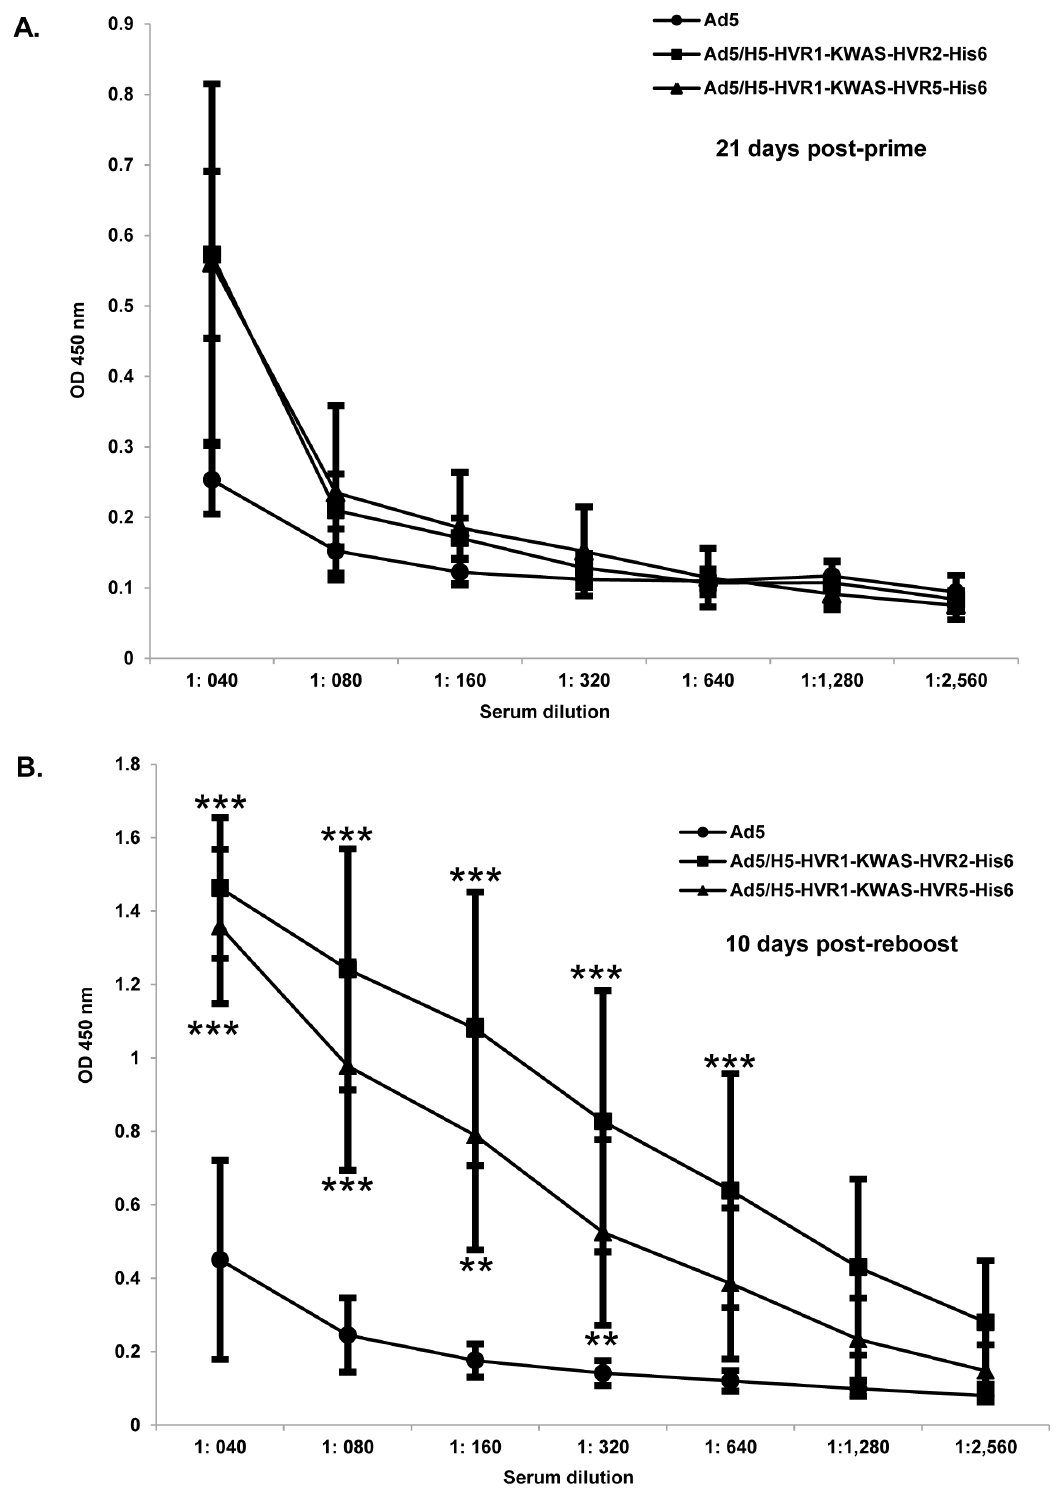
Figure 5. Multivalent vectors elicit an invivo anti-KWAS immune response. BALB/c mice (n=8) were primed, boosted, and reboosted with 1 6 10 10 VP of Ad vectors (Figure 4A). A–B) Post-prime and post-reboost serum was collected at various time points for ELISA binding assays. 1 m M of purified KWAS (PCEWDEAELDKWASNLEEEDDDNE) antigenic peptide was bound to ELISA plates. Residual unbound peptide was washed from the plates. The plates were then incubated with immunized mice serum and the binding was detected with HRP conjugated secondary antibody. OD absorbance at 450 nm represents KWAS antibody levels in sera. The values are expressed as the mean 6 standard deviation. The *** indicate a P value # 0.001, and ** indicate a P value # 0.01.